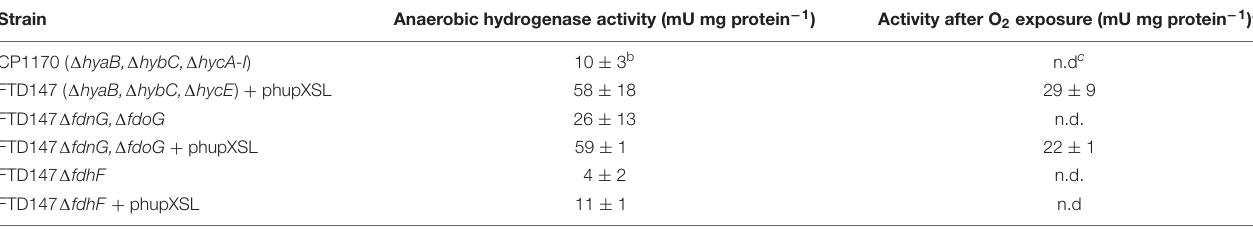
TABLE 2 | H 2 :BV oxidoreductase activities of E. coli strains carrying phupXSL. Strain